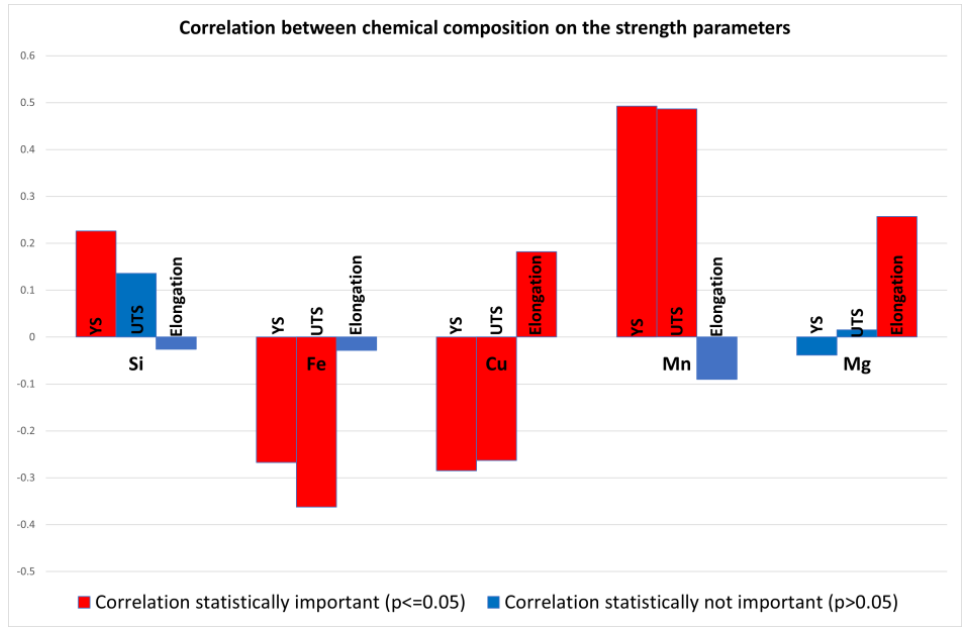
Figure 7. Correlation between chemical composition and strength parameters.